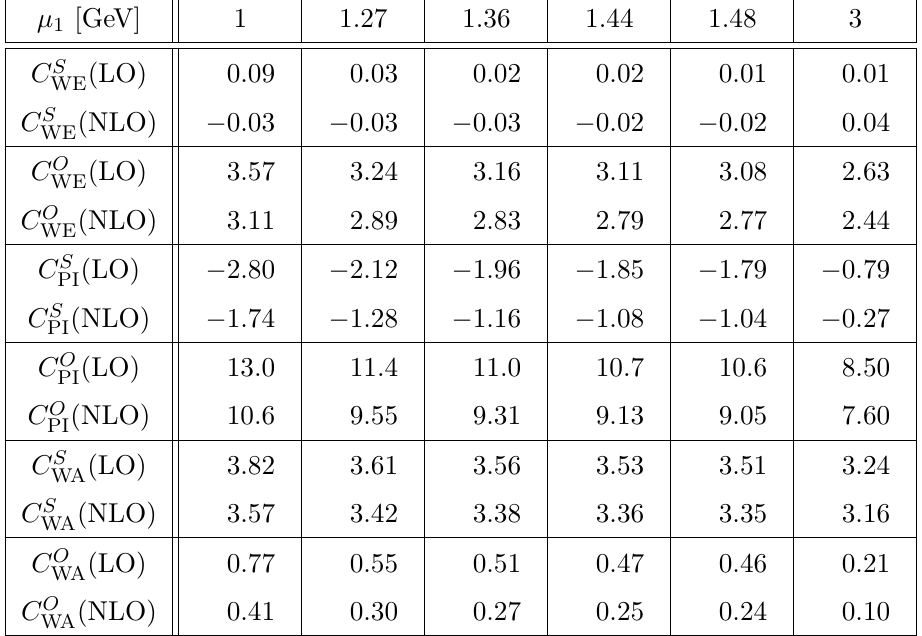
, respectively at LO- and NLO-QCD, for WE , PI , WA 1